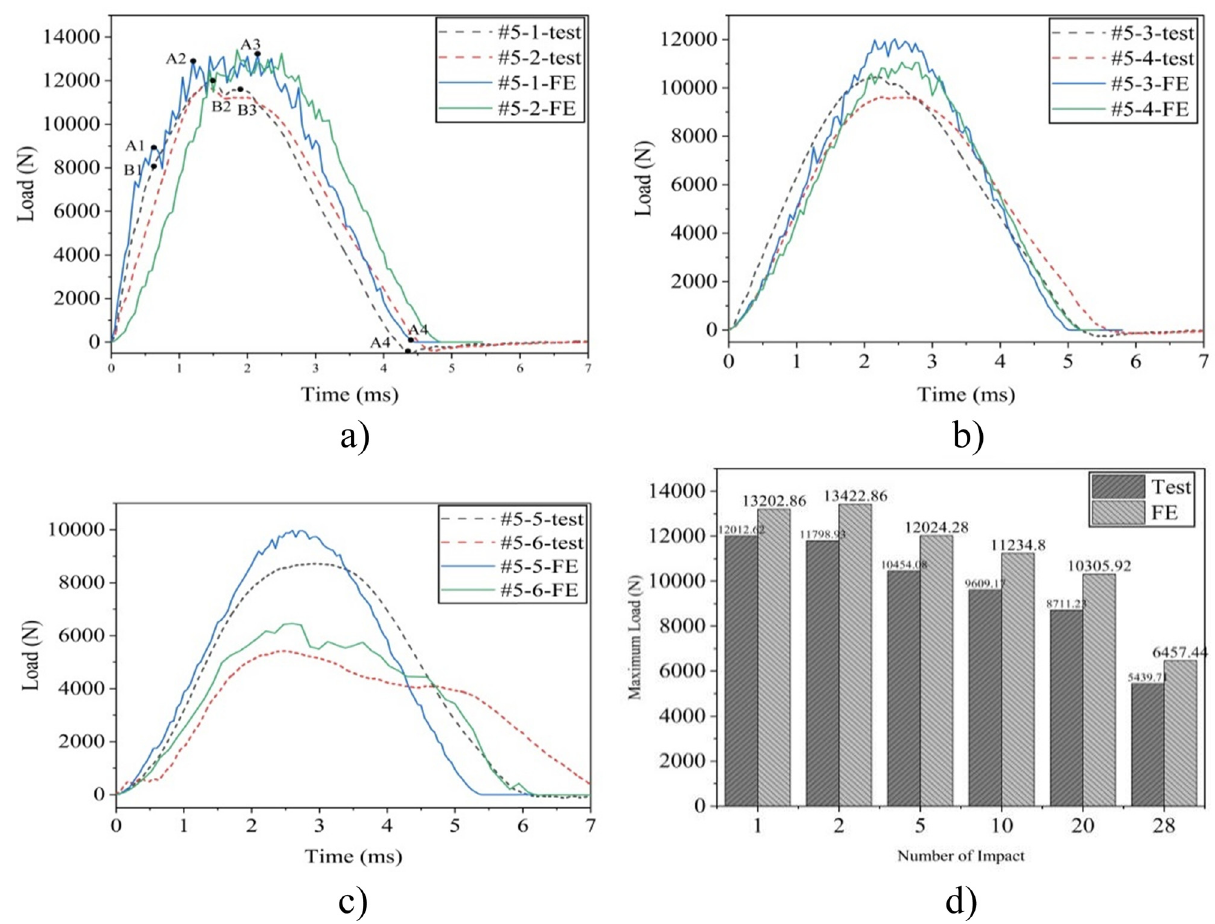
Figure 14: Load comparison between test process and simulation process: ( a ) 5 - 1 and 5 - 2 are the impact times of 1 and 2, respectively. ( b ) 5 - 3 and 5 - 4 are the impact times of 5 and 10, respectively. ( c ) 5 - 5 and 5 - 6 are the impact times of 20 and 28, respectively. ( d ) Peak impact load